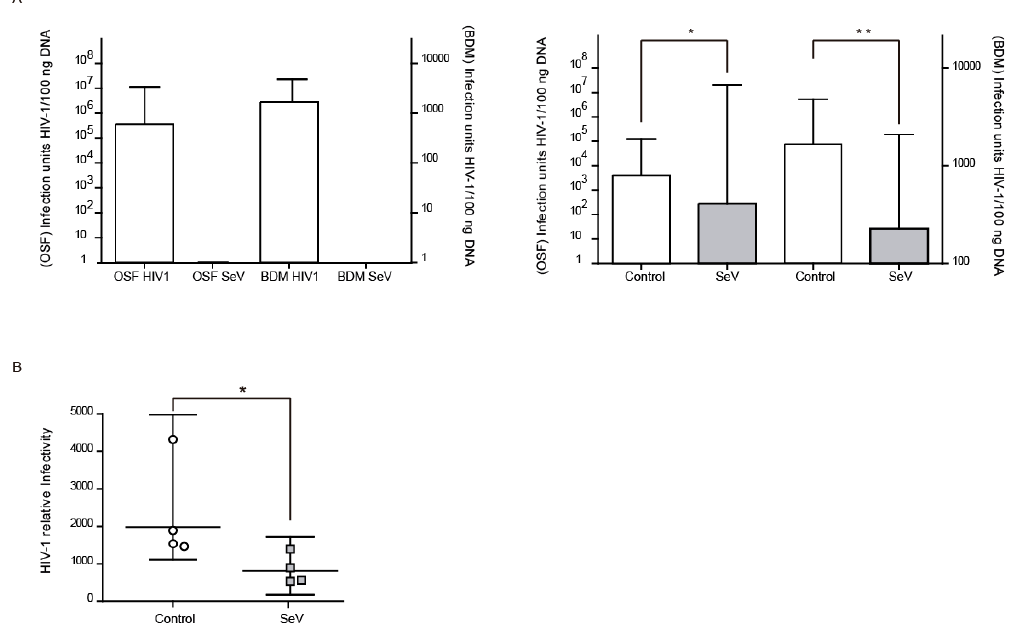
Figure 4. Pseudotyped Human Immunodeficiency virus (HIV-1) restriction after Sendai virus (SeV) infection. ( A , left panel) HIV-1-GFP proviral load in ovine skin fibroblasts (OSFs; left axis) and blood-derived macrophages (BDMs; right axis) infected with HIV-1 GFP-based vector or SeV-infected. Values represent the geometric mean copy values ( ± 95% confidence interval (CI)) per 100 ng of total DNA. ( A , right panel) GFP proviral copies measured in uninfected and SeV-infected OSF and BDM transduced with HIV-1 GFP vector. Values are the geometric mean copies ( ± 95% CI) per 100 ng of total DNA. Di ff erences were statistically analyzed using unpaired T test (one-tailed), * p < 0.05. ( B ) Relative infectivity in 293-T cells of HIV-1-GFP pseudovirus produced in uninfected 293-T cells (control; white bars) or infected with SeV (SeV; grey bars) in fresh 293-T cells. Values are the geometric mean ( ± 95% CI) of at least three independent experiments. Di ff erences were statistically analyzed using paired T test (one-tailed), * p < 0.05, ** p < 0.01.